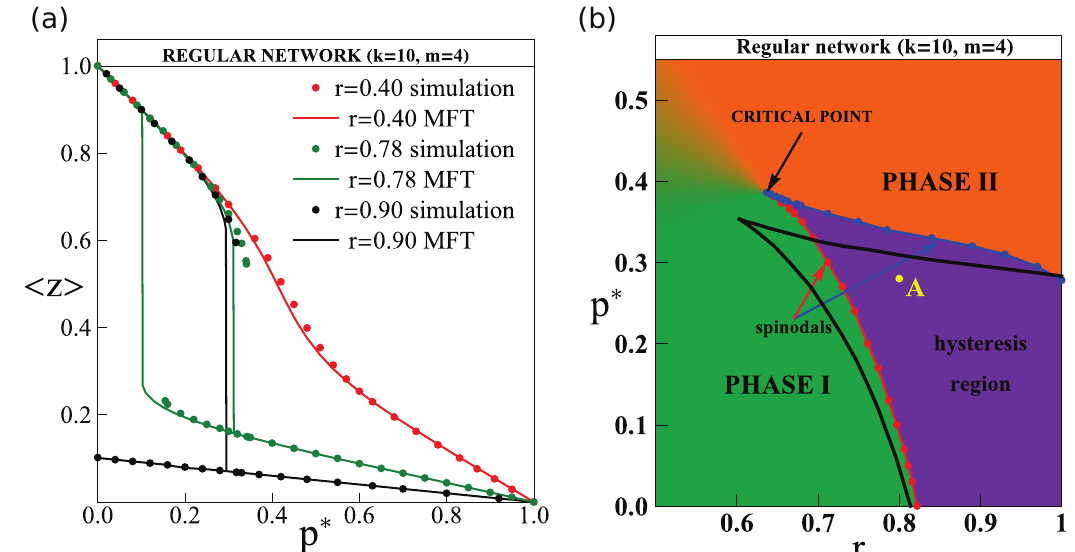
Figure 10. Critical behavior of the system with first order phase transition and hysteresis. ( a ) Equilibrium average fraction of active nodes (cid:104) z (cid:105) as a function of p ∗ , which represents the average fraction of internally-failed nodes. For three different values of r , simulation results (symbols) and the mean-field theory (MFT) prediction (solid lines) agree well with each other. Parameters for random regular networks, N = 107 , (cid:104) k (cid:105) = 10 and m = 4 , are used in this example. ( b ) The phase diagram in model parameters ( r, p ∗ ) exhibits two phases. Phase I (green region) represents a high activity collective network mode; Phase II (orange) represents a low activity mode. The hysteresis region (purple) is bounded with spinodals denoted by red and blue lines. After